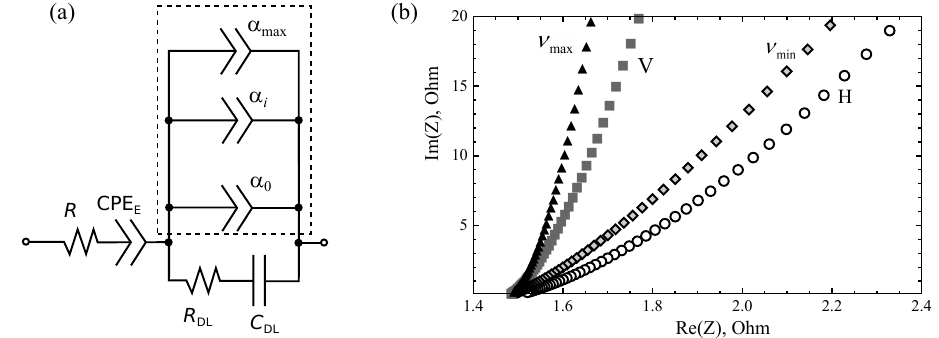
Figure 8. ( a ) Distributed order fractional circuit model of PMSC. ( b ) Nyquist diagrams for four cases of fractional PMSC model.